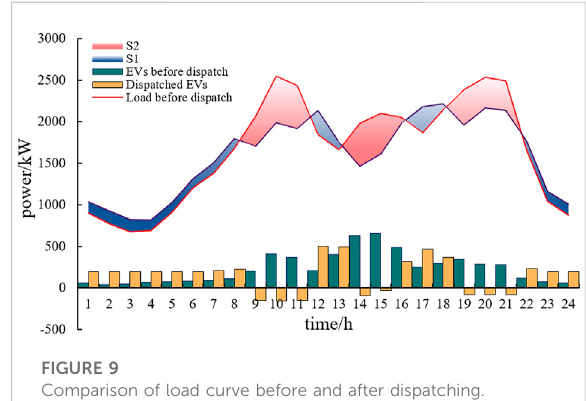
FIGURE 9 Comparison of load curve before and after